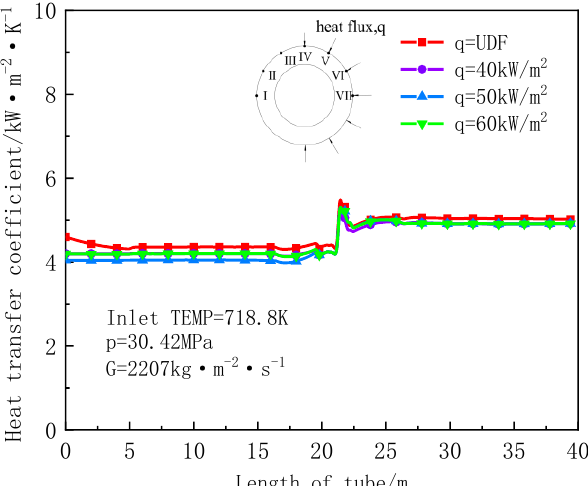
Figure 10. Heat transfer coefficient of the tube length at different heat fluxes ( p = 30.42 MPa, G = 2207 G = 2207 kg/(m 2 · s), q = 39.8~71.2 kw/m 2 kg/ ( m 2 ·s ) , q = 39.8~71.2 kw/m 2 ).